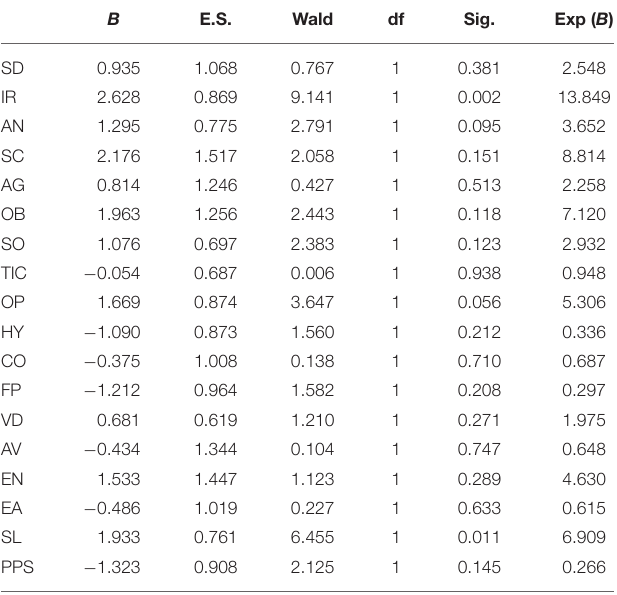
TABLE 11 | Regression between section II and symproms_increased.